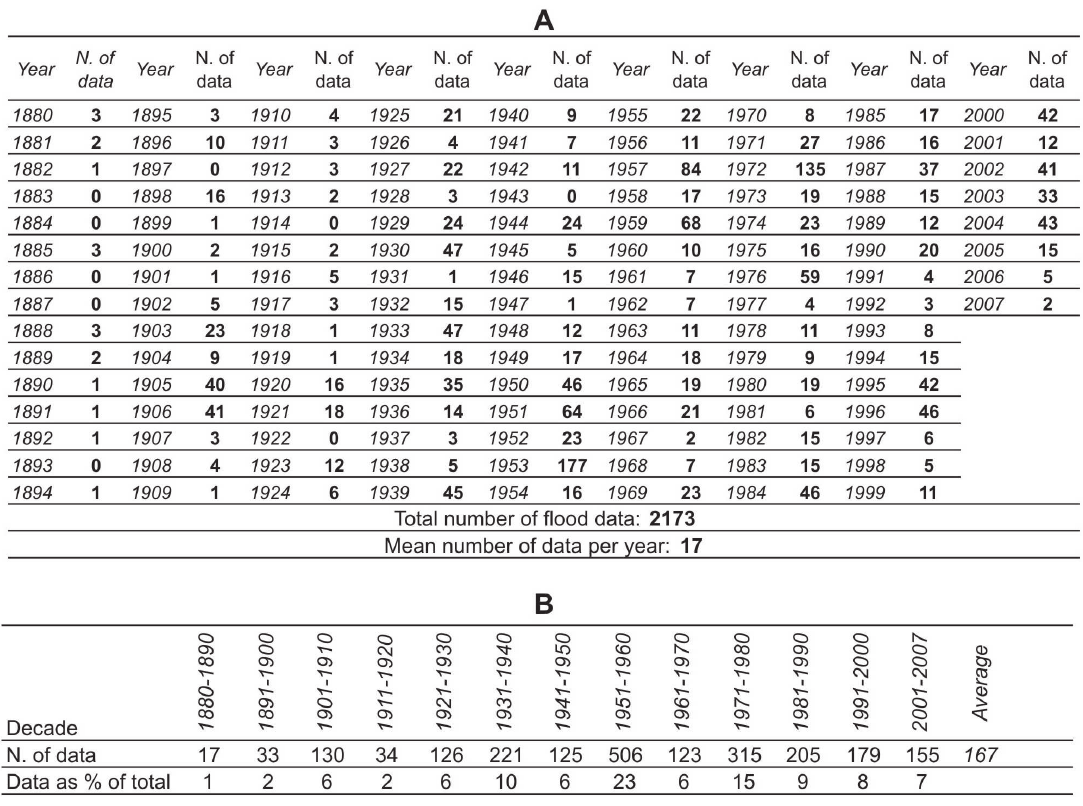
Fig. 2. Number of flood data and annual distribution. (A) : number of flood data collected for each year of the study period. (B) : Data distribution per